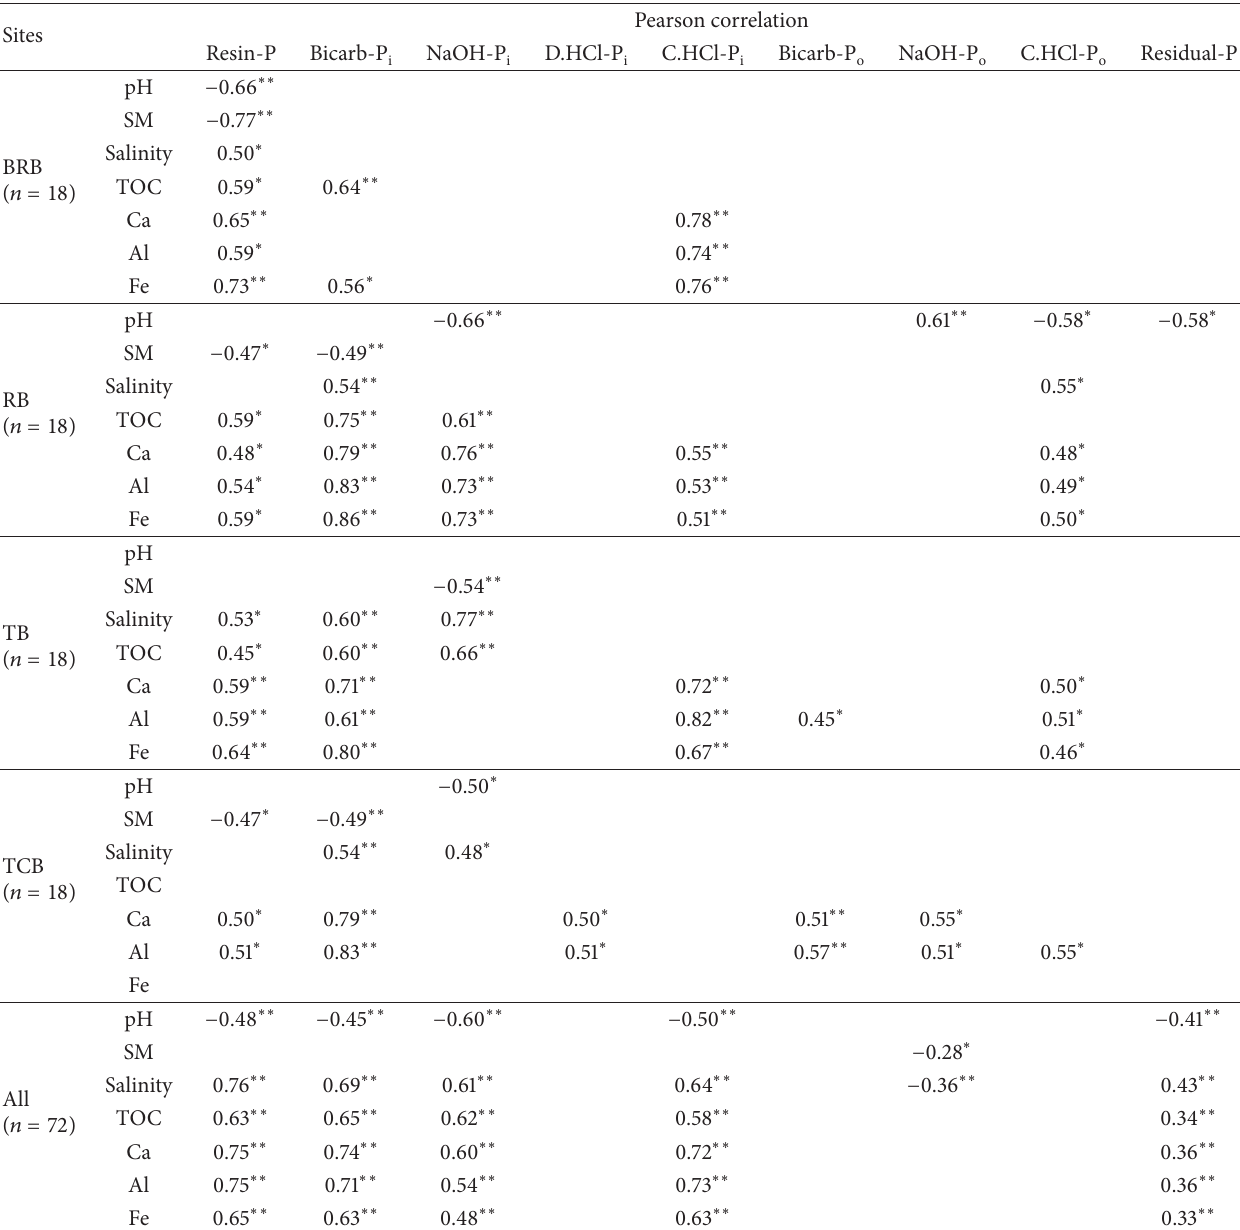
Table 4: Pearson correlation coefficients between P fractions and soil geochemical properties.